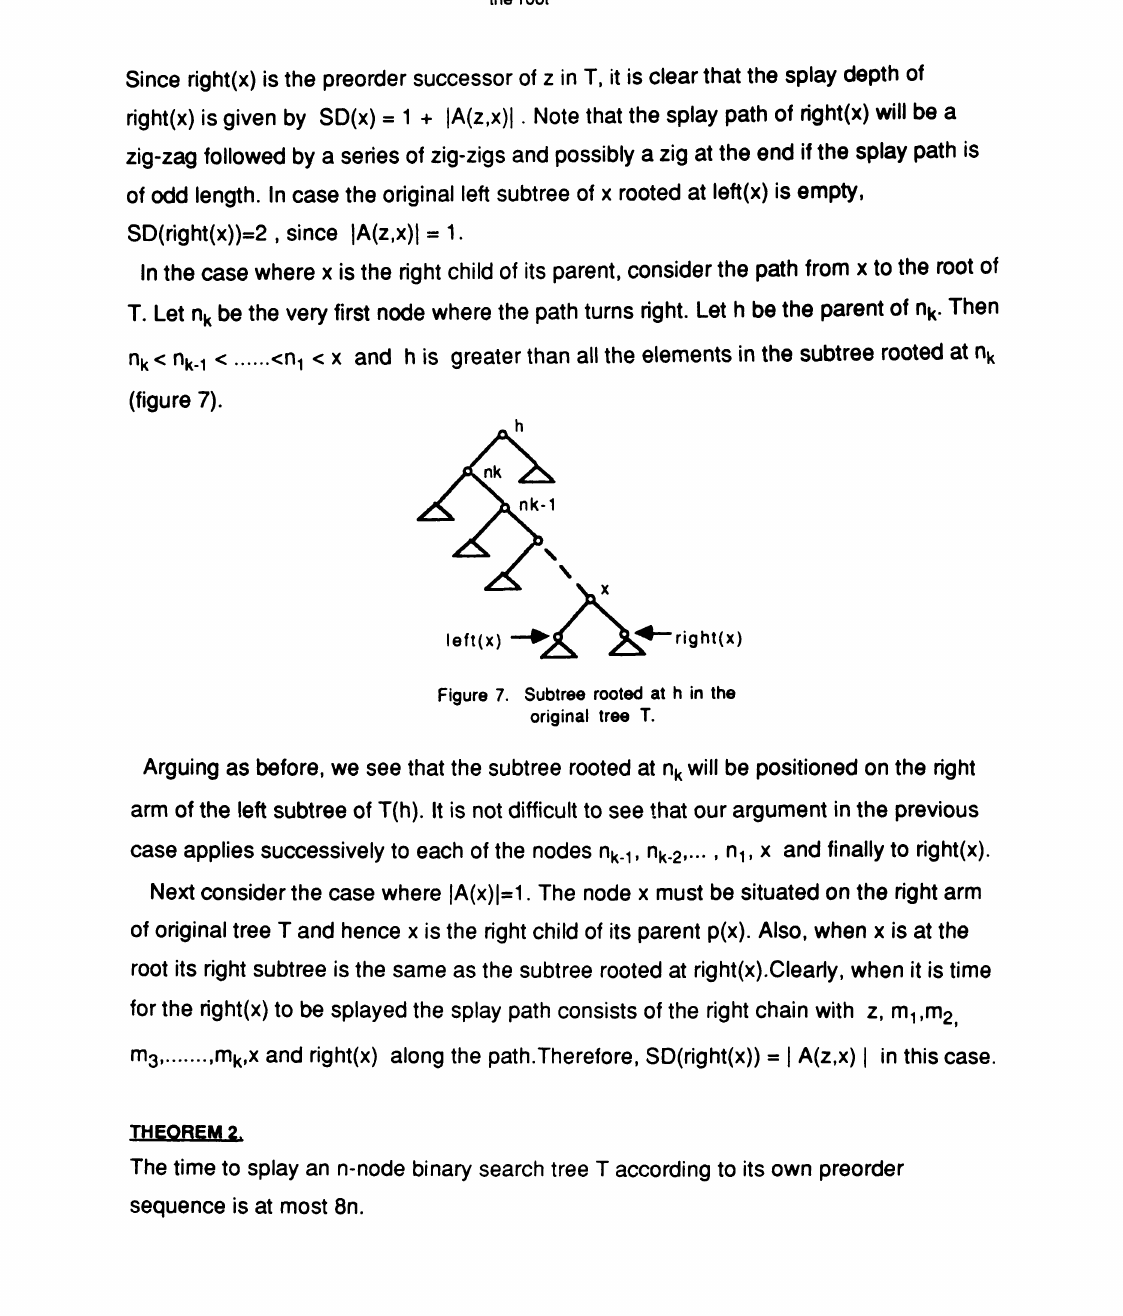
Figure 6. Splay tree with z (preorder predecessor of right(x) at the root